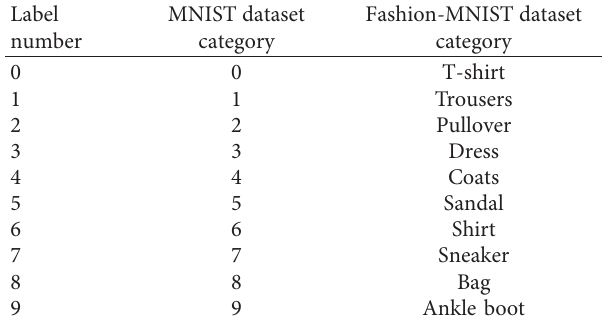
Table 3: Label number and category of the MNIST dataset and fashion-MNIST dataset.